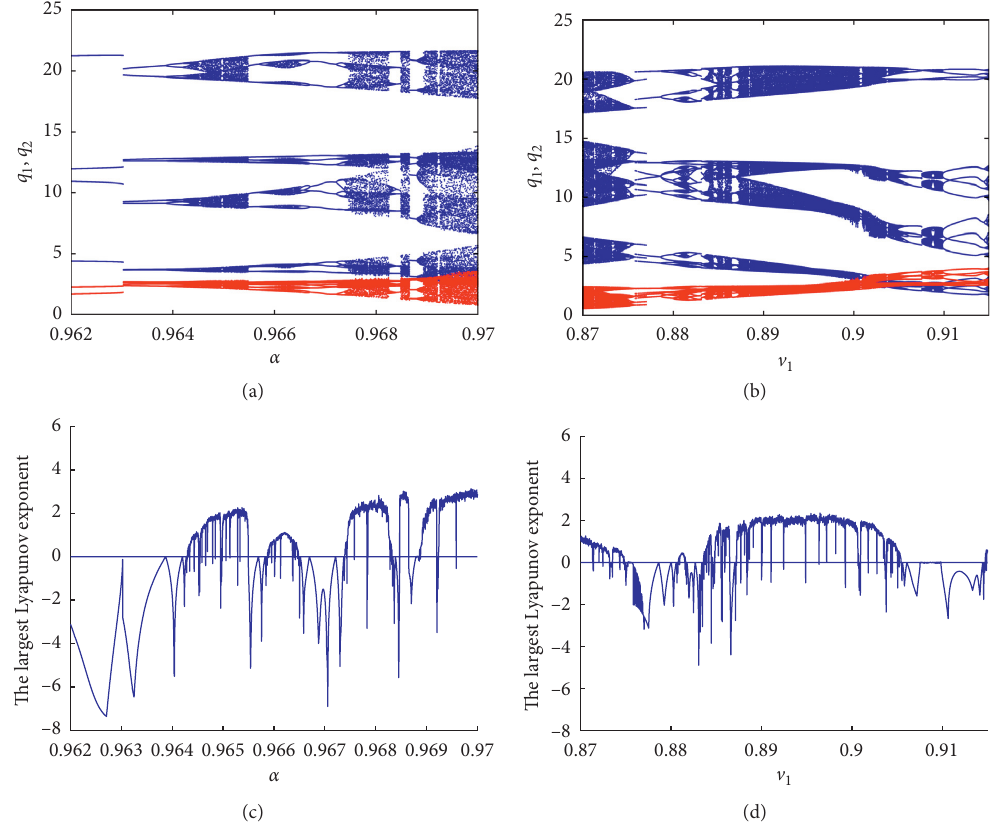
Figure 3: The 1-D bifurcation diagram and the corresponding largest Lyapunov exponent with a − c � 0 . 8. (a) The 1-D bifurcation diagram with varying values of α when v v 2 when α � 0 . 9653. (c) The corresponding largest Lyapunov exponent of Figure 3(a). (d) The corresponding largest Lyapunov exponent of Figure